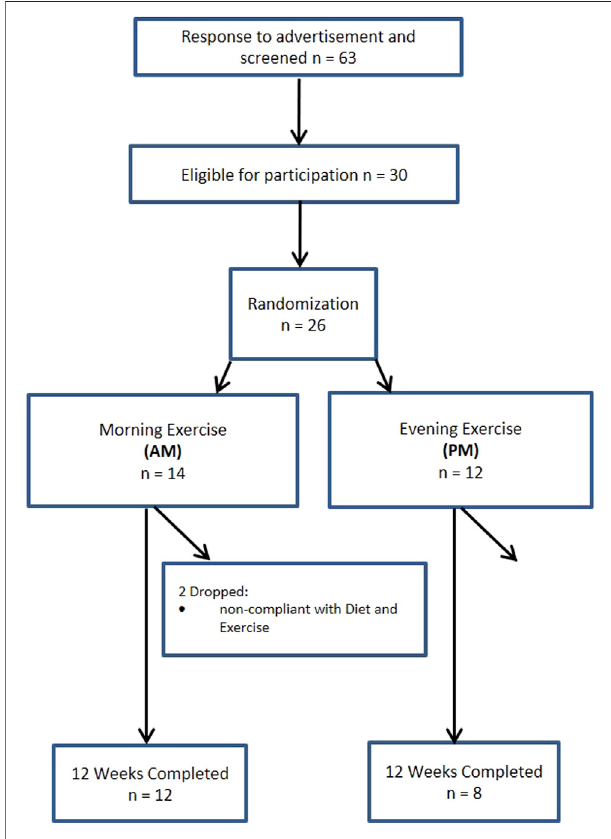
FIGURE 1 | Consort experimental design for women. FIGURE 2 | Consort experimental design for